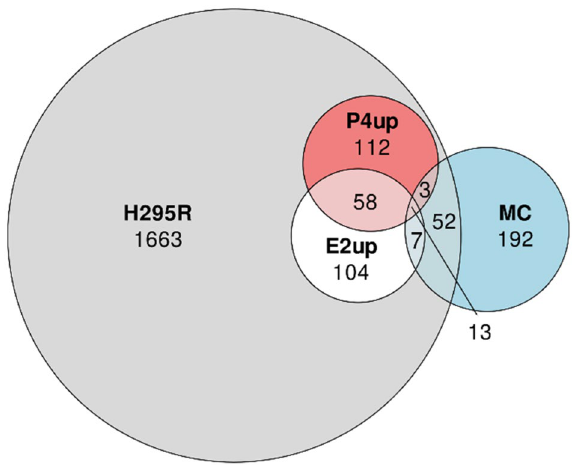
Figure 10. Venn diagram between active E2up, P4up, H295R and MC chemical sets.